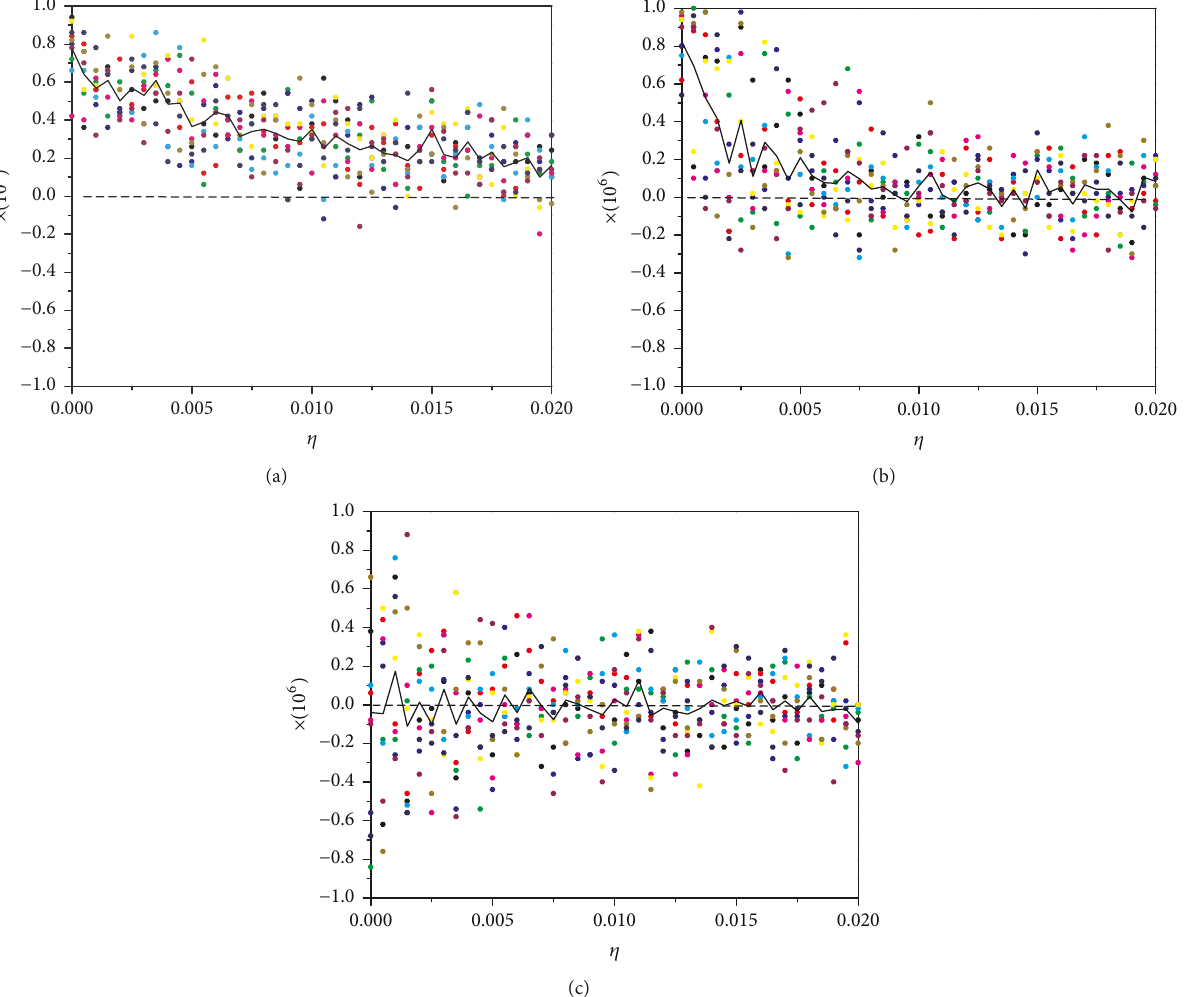
Figure 7: Dependence of mean field (at time 10 6 ) on 𝜂 (the ratio of time in which units behave individually) for bottom-up SOTC model (a), top-down SOTC model (b), and ordinary DMM with tuned parameter 𝐾 𝑐 = 1.5 (c). Each set of colored dots corresponds to one experiment and the black solid lines are the average of